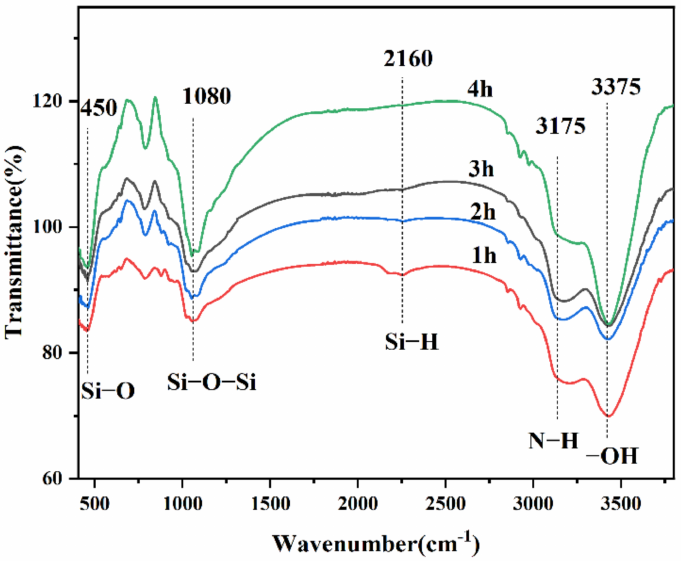
Figure 1. Infrared absorption spectra of SiON solid with different pyrolysis